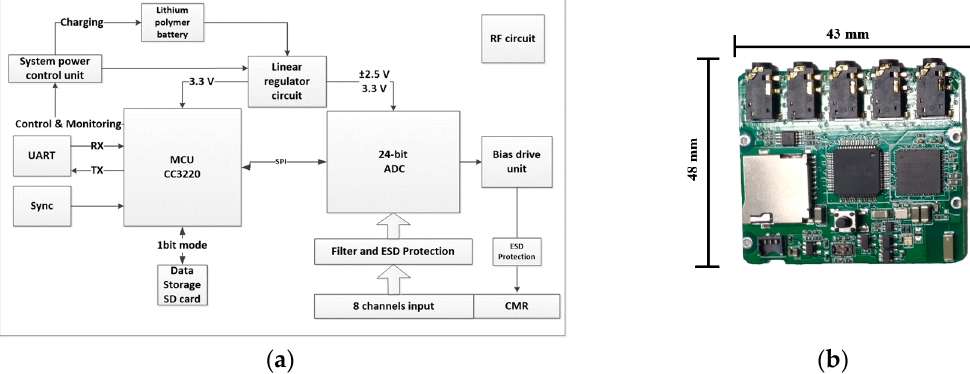
Figure 3. ( a ) Hardware diagram of the electrophysiology sensor. ( b ) The electrophysiology